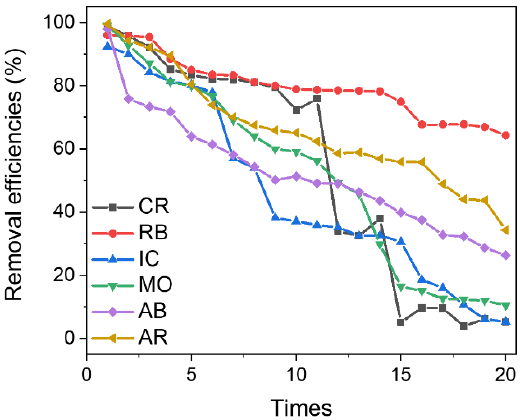
Figure 8. Long-term removal efficiencies of the PAN-MIL101(Fe)-NH 2 NFM for Congo red (CR), rhodamine B (RB), indigo carmine (IC), methyl orange (MO), acid blue 93 (AB), and acid red 27 (AR).